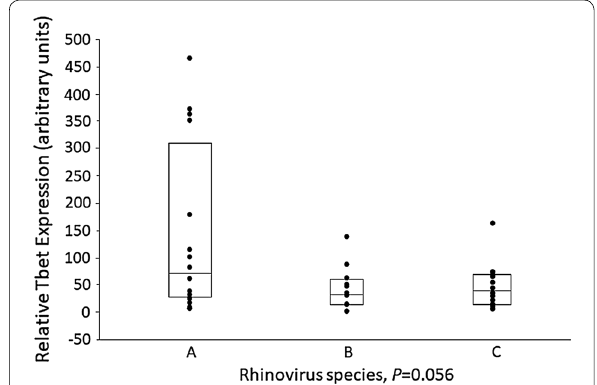
Fig. 4 Relative tonsillar expression of Tbet. Comparison of tonsil samples between 16 RV-A, 12 RV-B and 14 RV-C positive patients (Table 3). Values are arbitrary units 10 4 relative to EF1α. Data × represents median with interquartile range. Tbet, T-box transcription